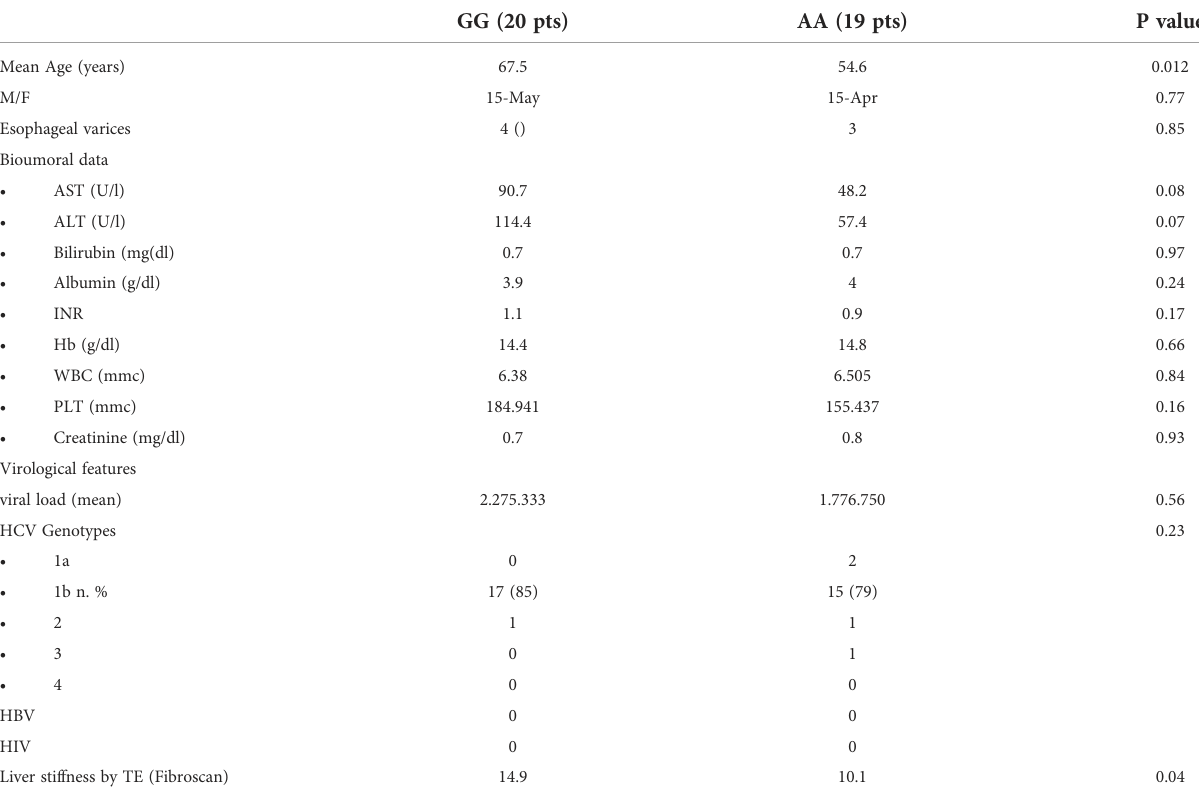
TABLE 1 Demographic, clinical, laboratory, and histological characteristics of CHC patients according to rs4374383 MERTK